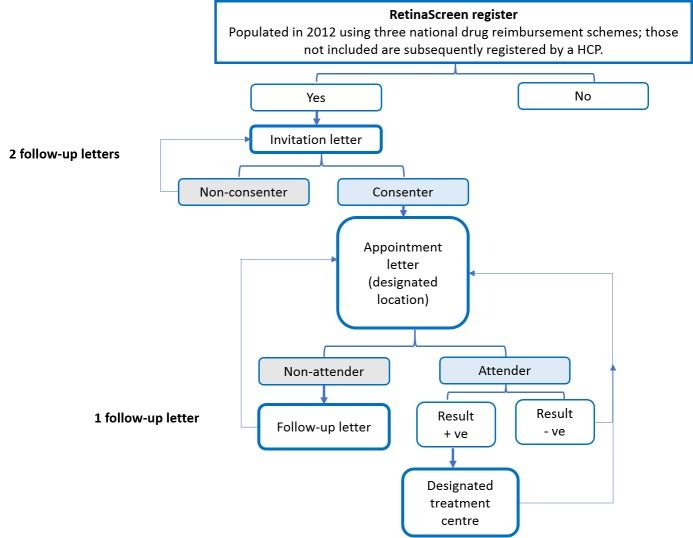
Flow diagram illustrating process of consenting and attending to the programme.HCP; Health Care Professional.